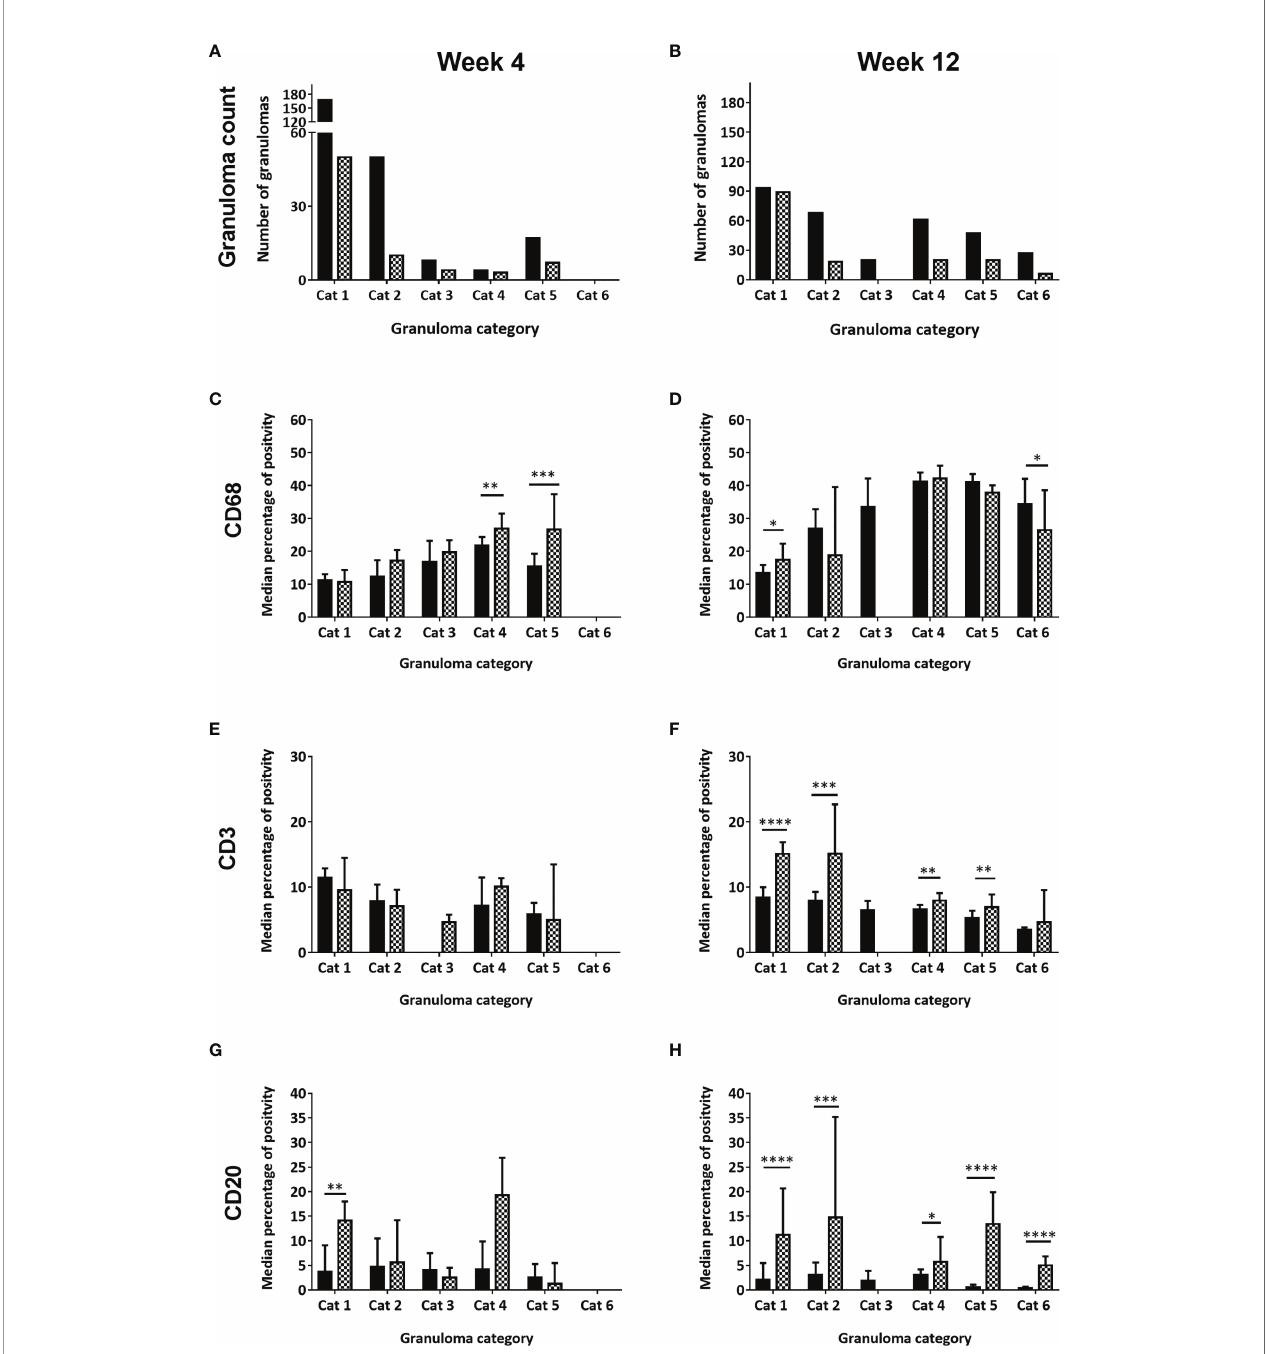
FIGURE 2 | Number of granulomas observed, scored and counted and the median percentage of positively stained immune cells (CD68+, CD3+, CD20+) in each granuloma category at week four and week twelve post challenge, for rhesus and cynomolgus macaques. Total number of granulomas counted in both rhesus and cynomolgus macaques at 4wpc (A) and 12wpc (B) . Black column represents rhesus macaques (4 per time point) and checked column represent cynomolgus macaques (4 per time point). Median percentage of positive cells in all granulomas counted in each category at 4wpc and 12wpc for: CD68+ macrophages (C, D) , CD3+ T cells (E, F) and CD20+ B cells (G, H) . Mann Whitney U test, bars represent median values, error bars represent 95% con fi dence interval. * P < 0.05, ** P < 0.01, *** P < 0.001, **** P = <